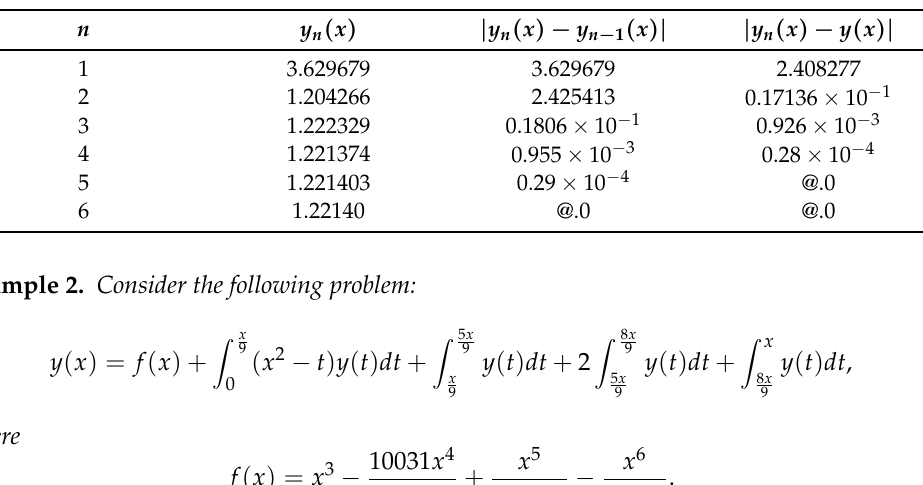
Table 3. Results of the CESTAC method for Example 1 and x =